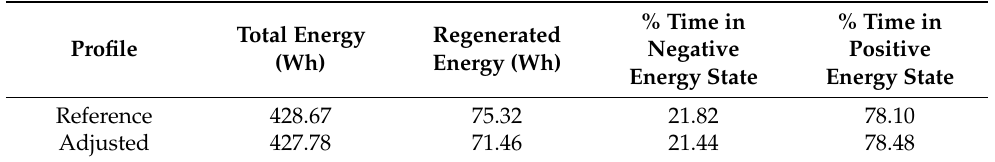
Table 12. Energy-related summary statistics under reference and adjusted speed profiles for the Lisbon case.